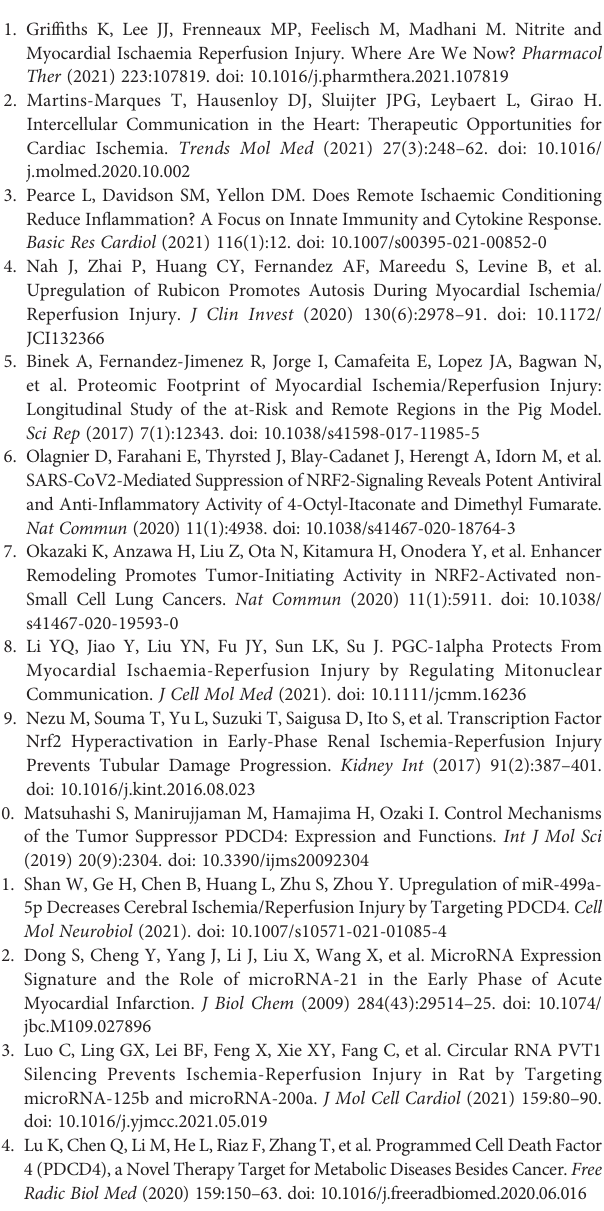
mouse analysis. (B – G) Percentage of immune cell in fi ltration in T cell subclass, CD4 + T cell subclass, CD8 + T cell subclass, B cell subclass, CD4 + T cell subclass, granulocytes subclass, or DC subclass. Supplementary Figure 3 | Correlation analysis between Neutrophil in fi ltration and the expression of Nfe2l2 or Pdcd4. (A) Correlation analysis between Neutrophil in fi ltration and the expression of Nfe2l2 (Nrf2). (B) Correlation analysis between Neutrophil in fi ltration and the expression of Pdcd4. Supplementary Table 1 | Gene list of Ccr1 + M1 macrophage signature. Supplementary Table 2 | The proportion of immune cells in fi ltrating (%) according to